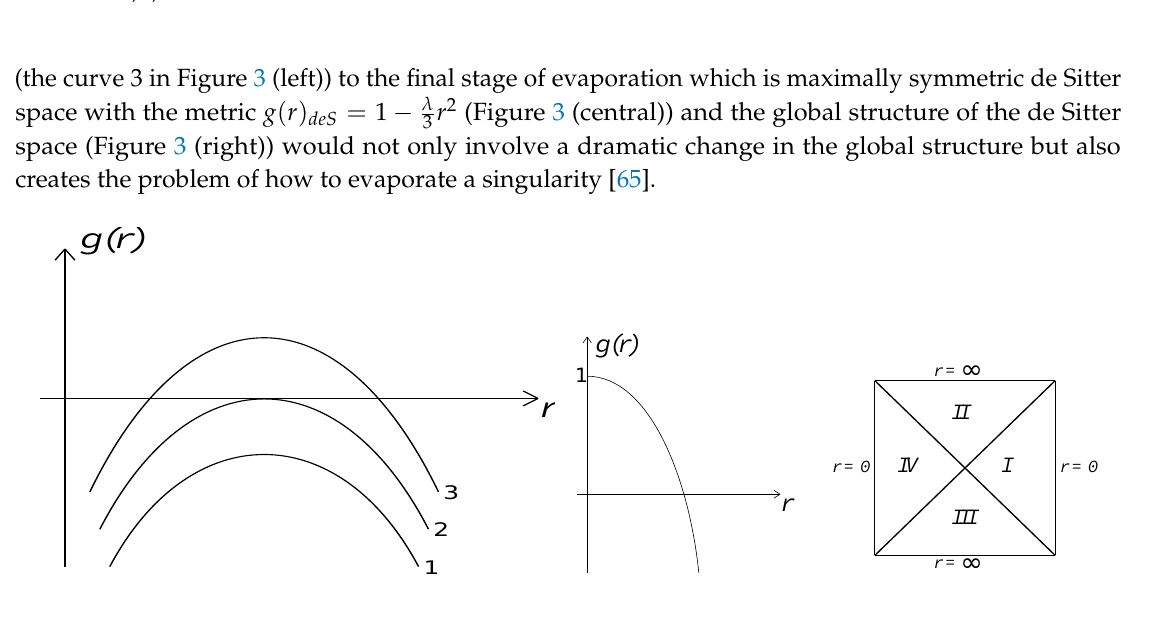
Figure 3. Evolution of the Schwarzschild-de Sitter black hole in the case of complete